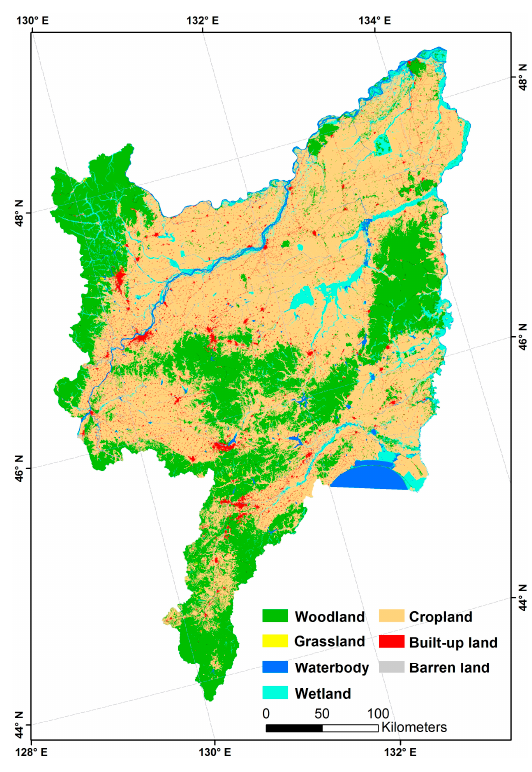
Figure 3. Spatial patterns of various land cover types in 2018 across the SJP.